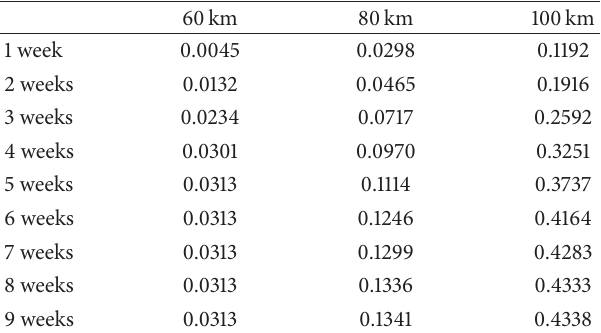
Table 4: AE as aftershocks from July 5, 2011 to September 5, 2011. Cumulative probability 𝐶 − ( r, 𝜏 ) for radius r ranging between 60 and 100km, and time 𝜏 varying from 1 week to 9 weeks. 60km 80 km 100km